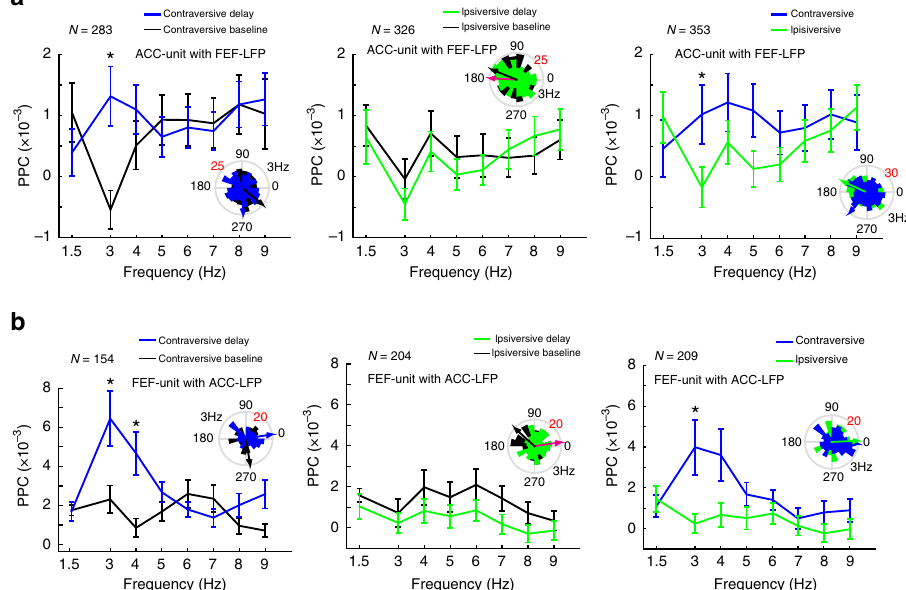
Figure 6 | Pairwise phase consistencies (PPCs) across delta and theta band. ( a ) PPC spike-field coherence spectrum of the population of the ACC-unit with FEF-LFP pairs across the delta and theta frequency range. Comparison between baseline and delay of contraversive saccades (left), comparison between baseline and delay of ipsiversive saccades (middle), and comparison between the contra- and ipsiversive saccades in the delay period (right). ( b ) PPC spike-field coherence spectrum of the population of the FEF-unit with ACC-LFP pairs across the delta and theta frequency range. Comparison between baseline and delay of contraversive saccades (left), comparison between baseline and delay of ipsiversive saccades (middle), and comparison between the contra- and ipsiversive saccades in the delay period (right). It should be noted that the same significant differences between ipsi- and contraversive trials were seen even after we compared the contra- versus ipsiversive conditions using a permutation test as described in the Methods section. Error bars denote s.e.m. in all panels. * P o 0.05, paired t -test. The rose plots on the side of each graph show the histogram of the coupling angles of the population of the ACC/FEF